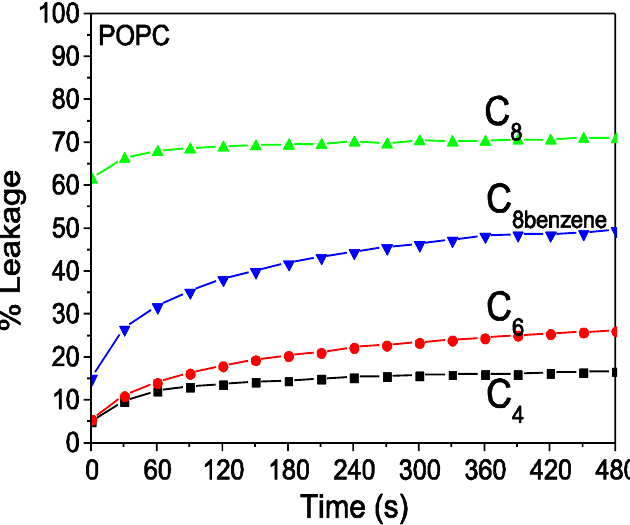
Figure 4. Calcein fluorescence dye leakage of 1-palmitoyl-2-oleoyl-sn-glycero-3-phosphocholine (POPC) vesicles after exposure to Polymer C 4 , C 6 , C 8 , and C 8(benzene) . Calcein-loaded LUVs of 20 μM final concentration. Each oligoguanidine polymer with a final concentration of 10 μg/mL. An excitation wavelength of 490 nm and an emission wavelength of 515 nm with 5-nm bandwidth slits.